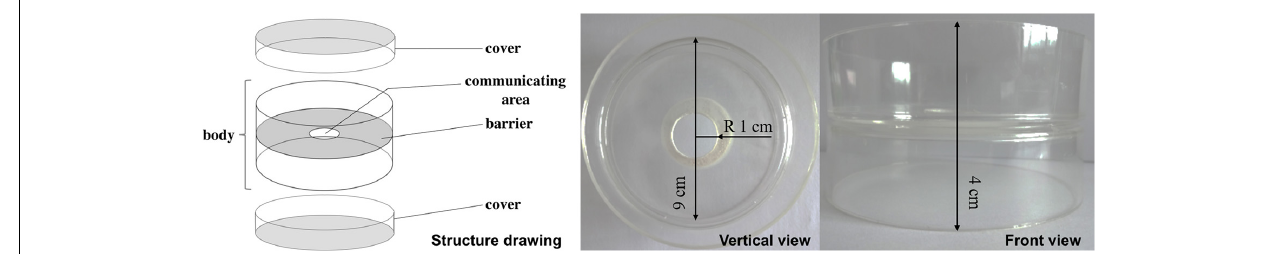
FIGURE 2 | Structure drawing, vertical view, and front view of the double-sided petri dish (DSPD).